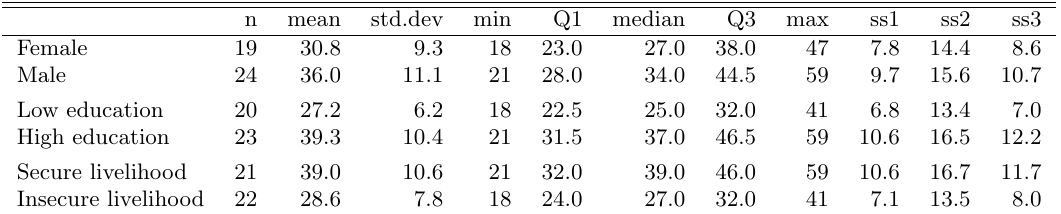
Table A1.1. Descriptive SOC statistics for three groups of respondents based on gender,